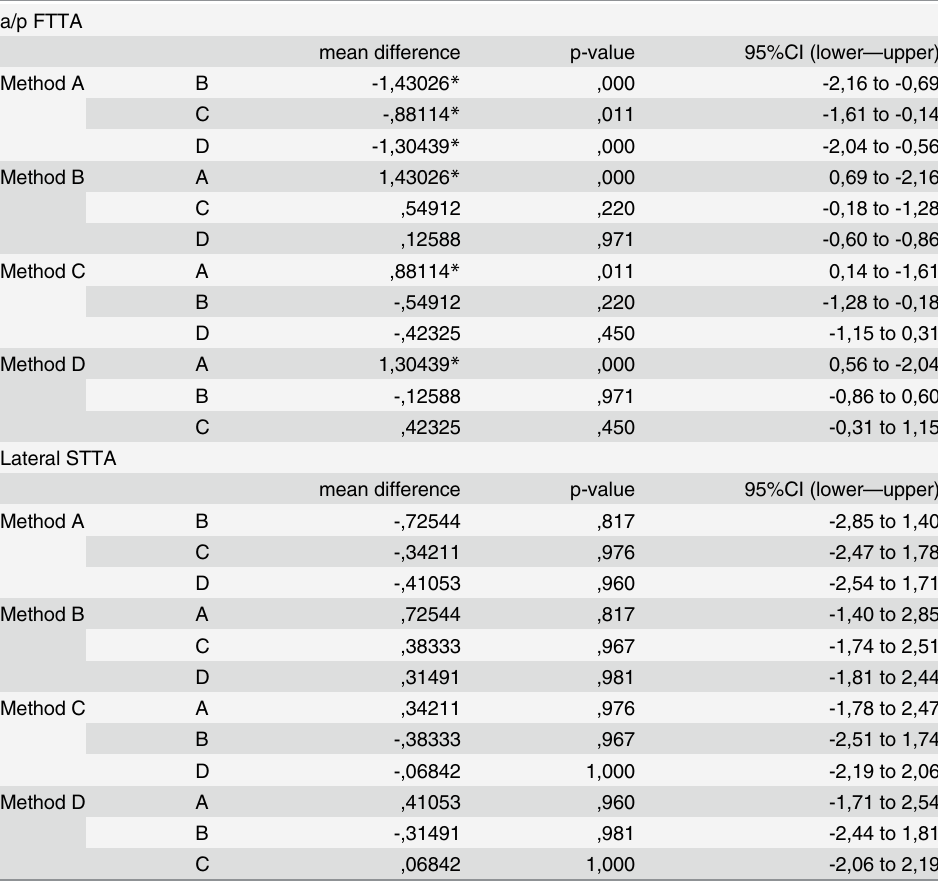
Table 3. Measurement Accuracy.